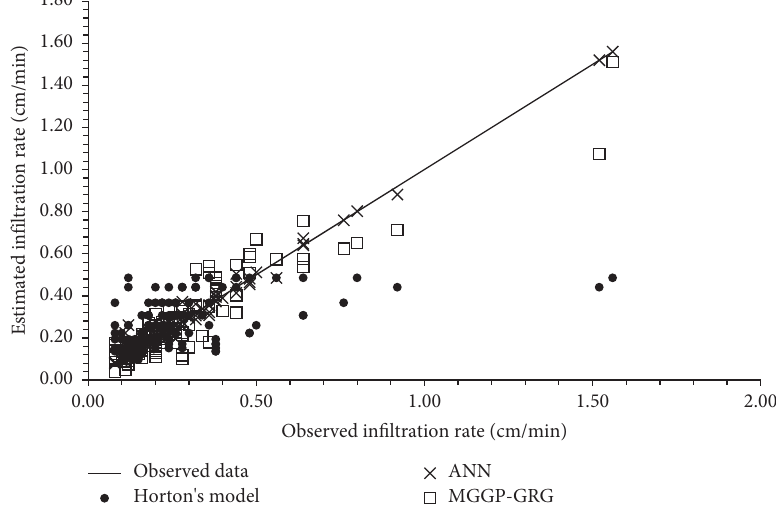
Figure 11: Estimated versus observed infiltration rates during the training